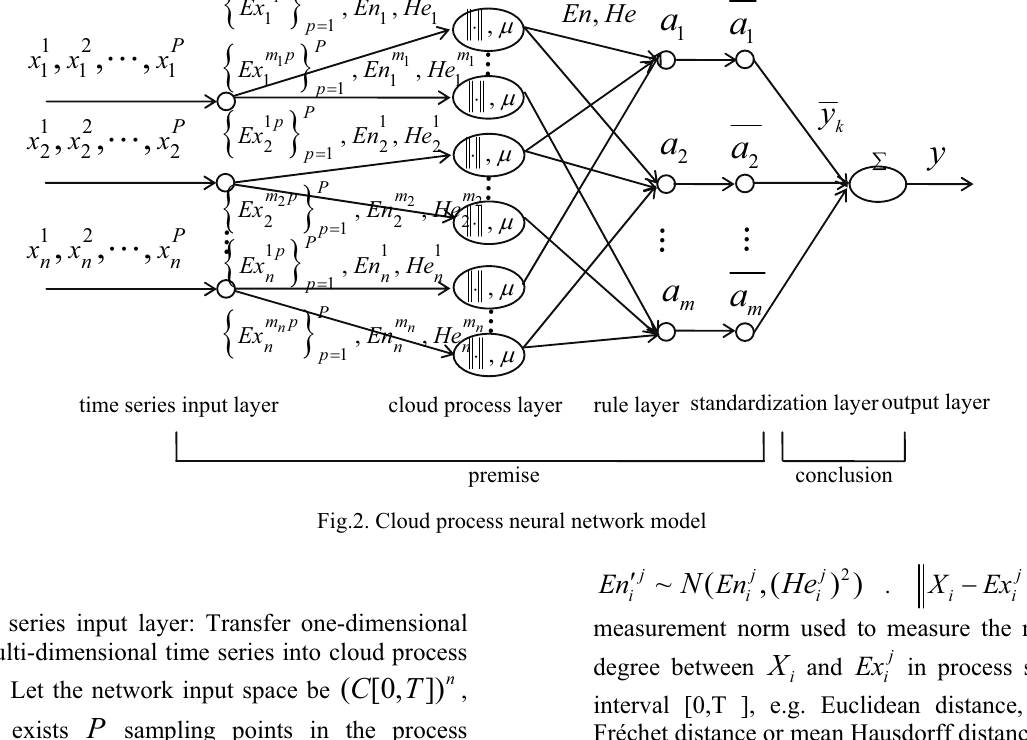
normal cloud model